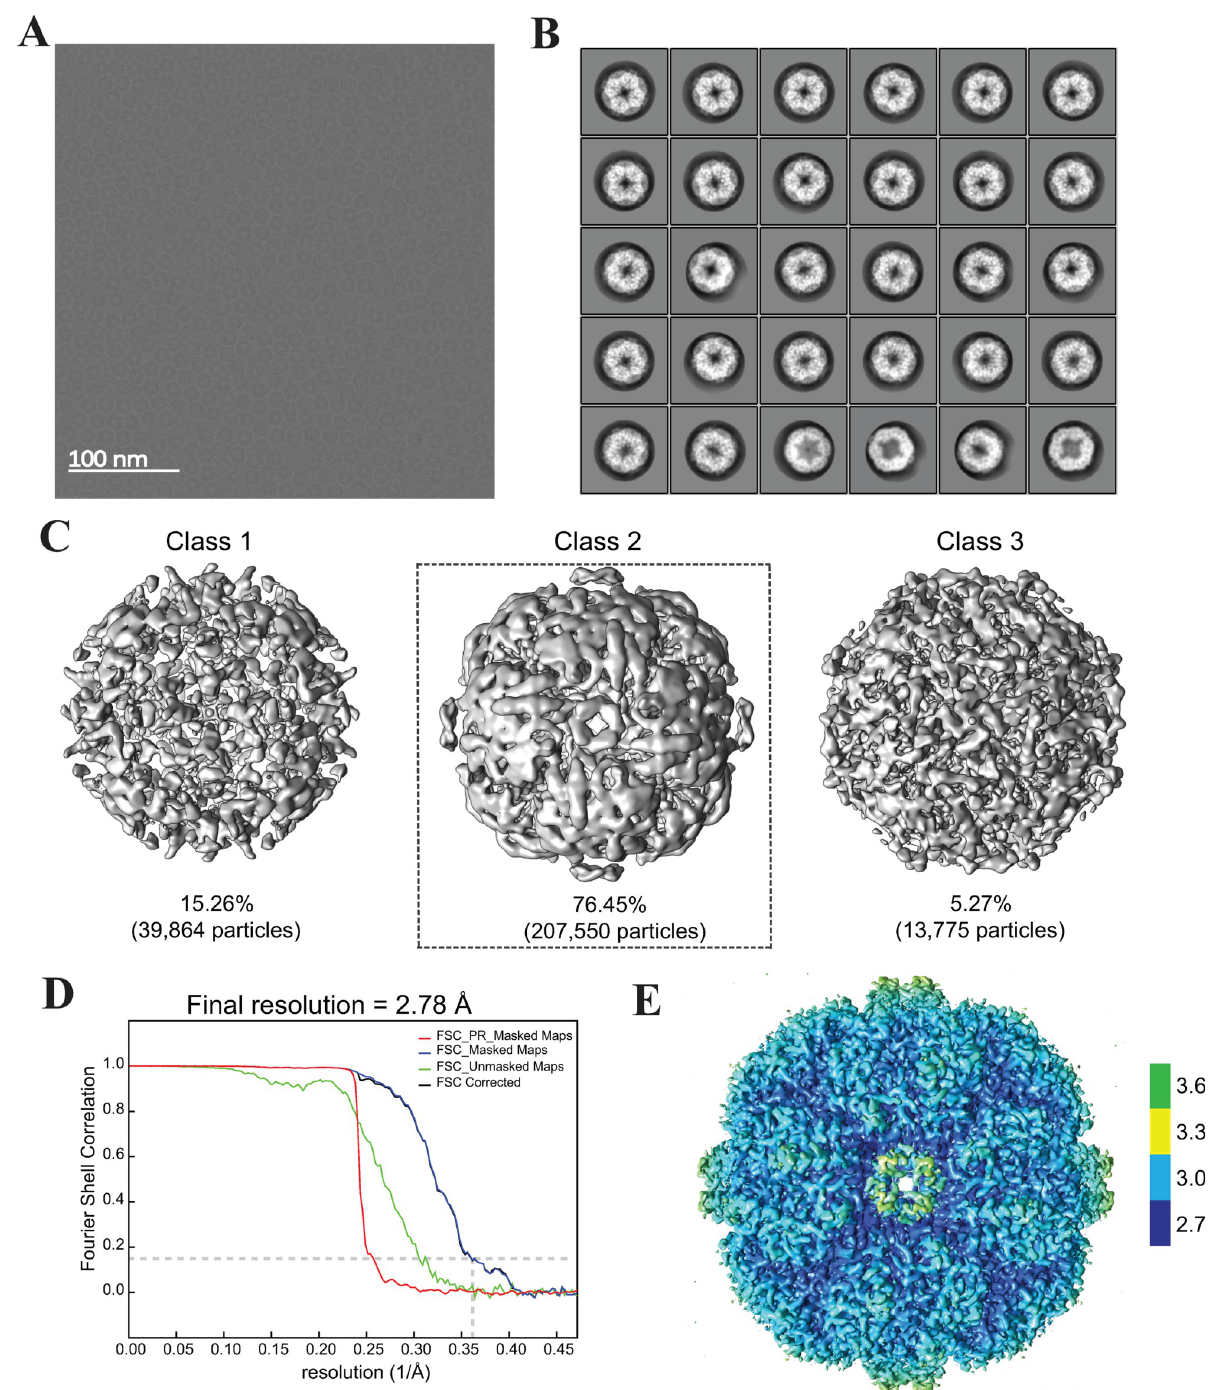
Fig 1. Cryo-EM imaging and 3D reconstruction of Sulfur Oxygenase Reductase (SOR) cryo-EM map. ( A ) Representative micrograph of SOR enzyme acquired in super-resolution mode at 130 kx magnification. The scale bar represents 100 nm. ( B ) The selected 2D classes contained 261,189 particles. All the shown 2D classes were subsequently used for 3D classification. (C) The 3D Class 2 reproduced the correct protein geometry with six- channel-like protrusions on its outer surface and constituted the major population of the particles (76.46%). The other two 3D classes (1 and 3) contained incomplete particles and were excluded from the refinement. ( D ) The Fourier shell correlation plot (FSC) shows the resolution of unmasked and masked maps. At FSC = 0.143, the final resolution of the cryo-EM map is 2.78 Å . ( E ) The final cryo-EM map is color-coded with the local resolution estimate obtained from RELION. The data processing pipeline flowchart for SOR is depicted in S2 Fig .